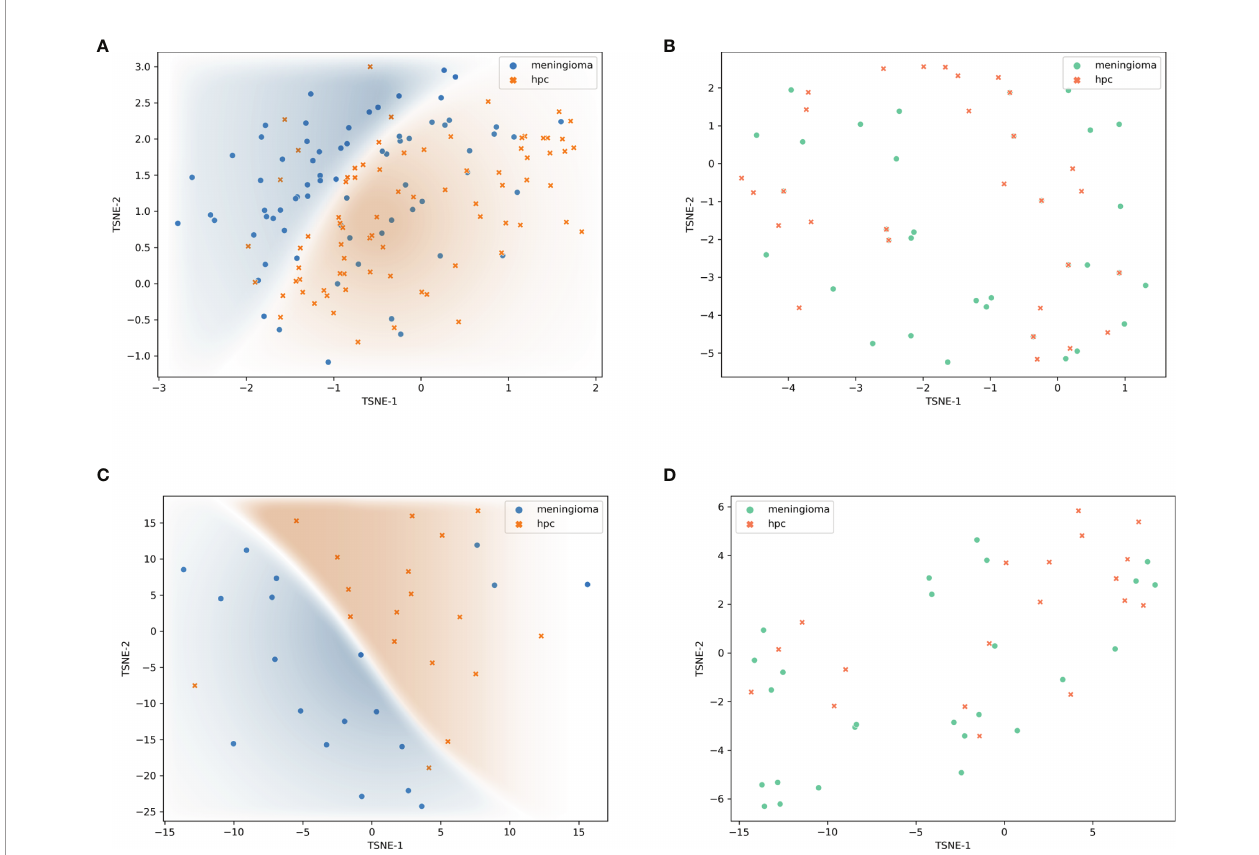
FIGURE 5 | Visualization of feature maps. Features extracted by transfer model and visualized by t-distributed stochastic neighbor embedding (t-SNE) showed distinct clustering in the training set (A) and validation set (C) , respectively. Features extracted by radiological feature classi fi cation model and visualized by t-SNE showed non-distinct clustering in the training set (B) and validation set (D) , respectively.